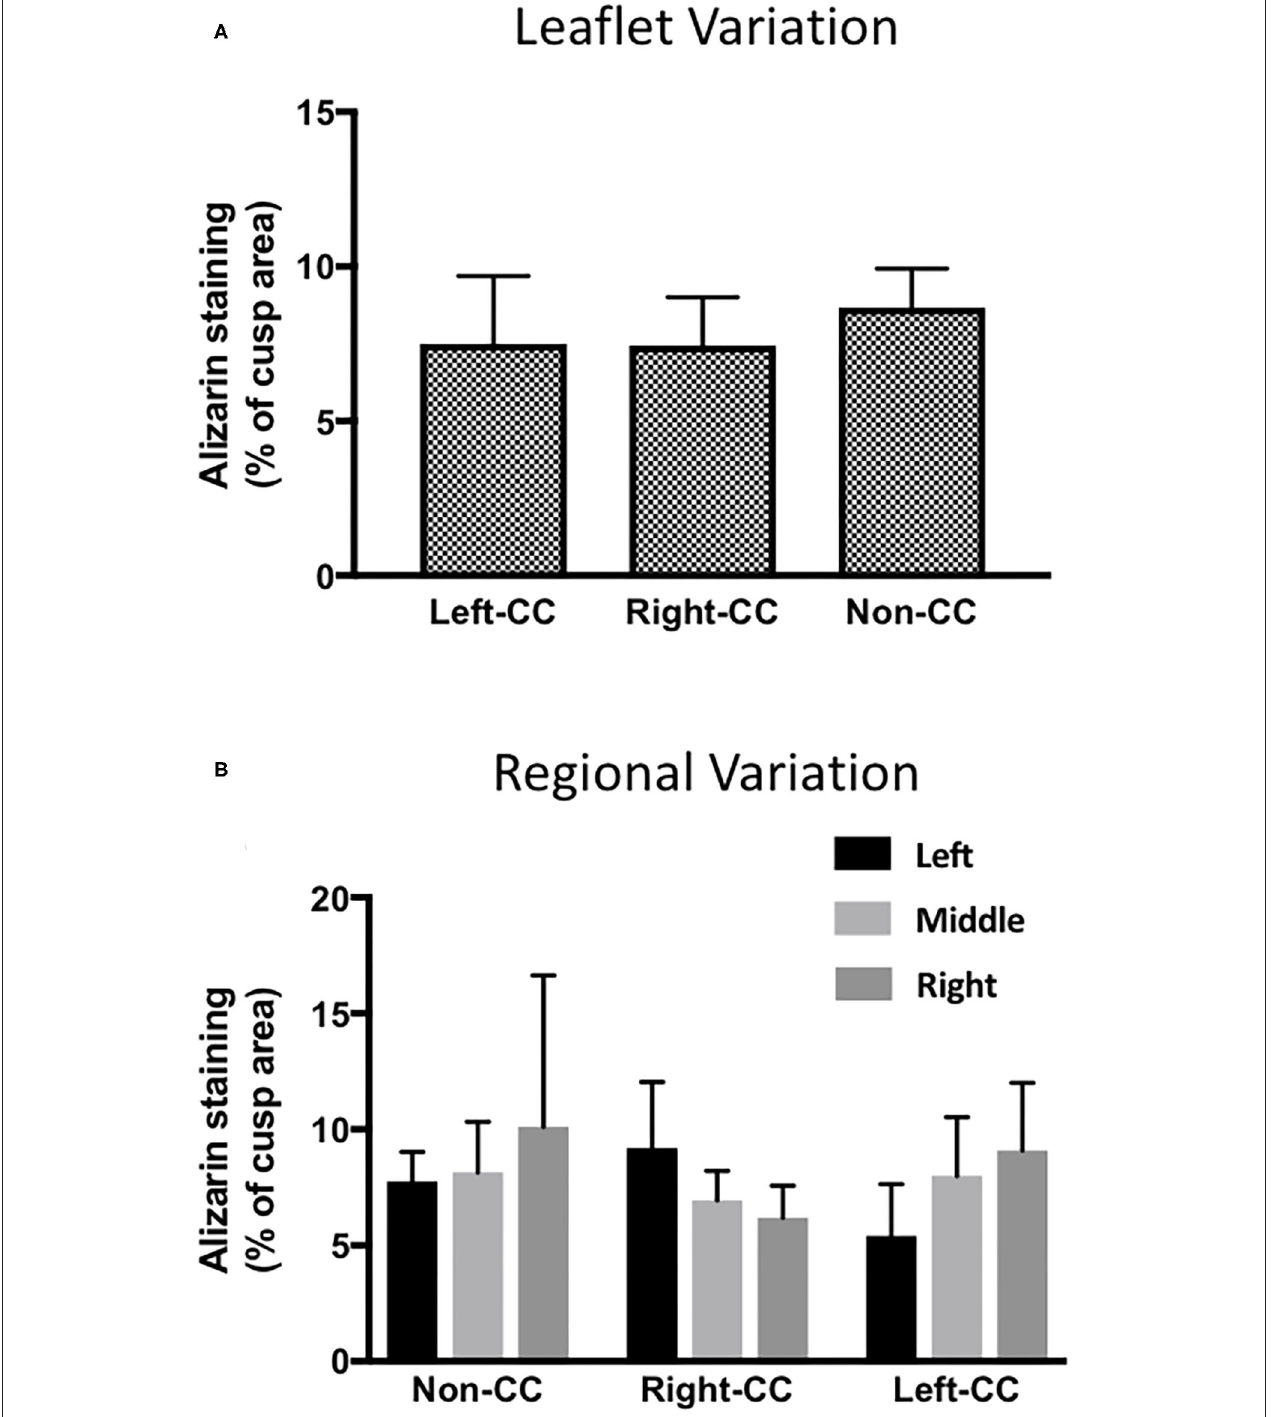
FIGURE 3 | Leaflet-specific and regional effects of LPS and phosphate. (A) Leaflet specific effects of 100ng/mL LPS and 3mM phosphate on calcium accumulation in the left-, right- and non-coronary leaflets of porcine aortic valves. Values are the mean of the measurement from the three regions of each leaflet ( p > 0.05, ANOVA; n = 6). (B) Comparison of the effect of 100ng/mL LPS and 3mM in the 3 regions of the left- right- and non-coronary leaflet assessed for calcium accumulation ( p > 0.05, ANOVA; n = 6).